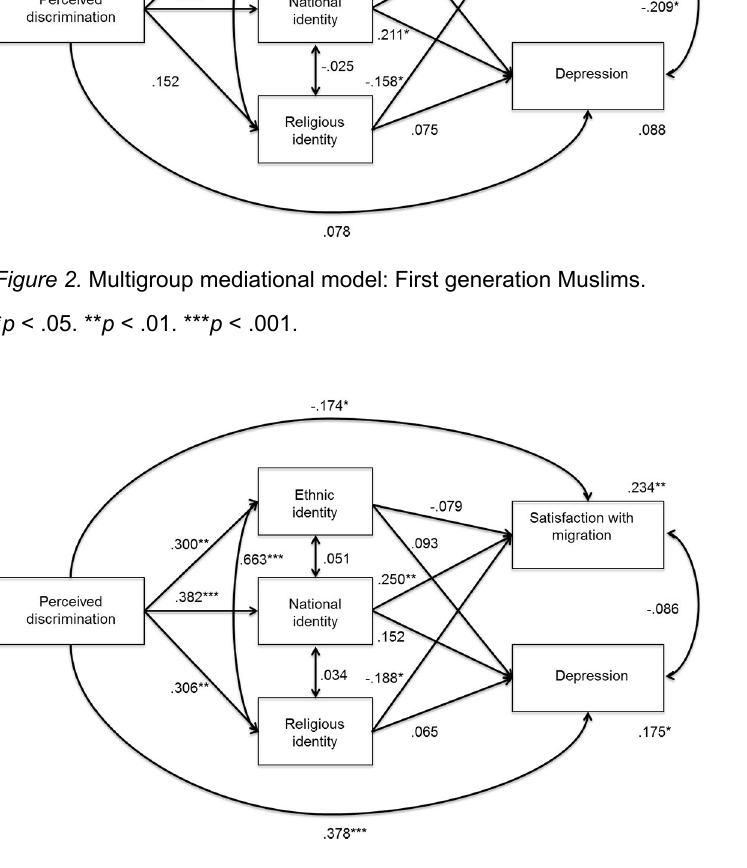
Figure 3. Multigroup mediational model: Second generation Muslims. * p < .05. ** p < .01. *** p <